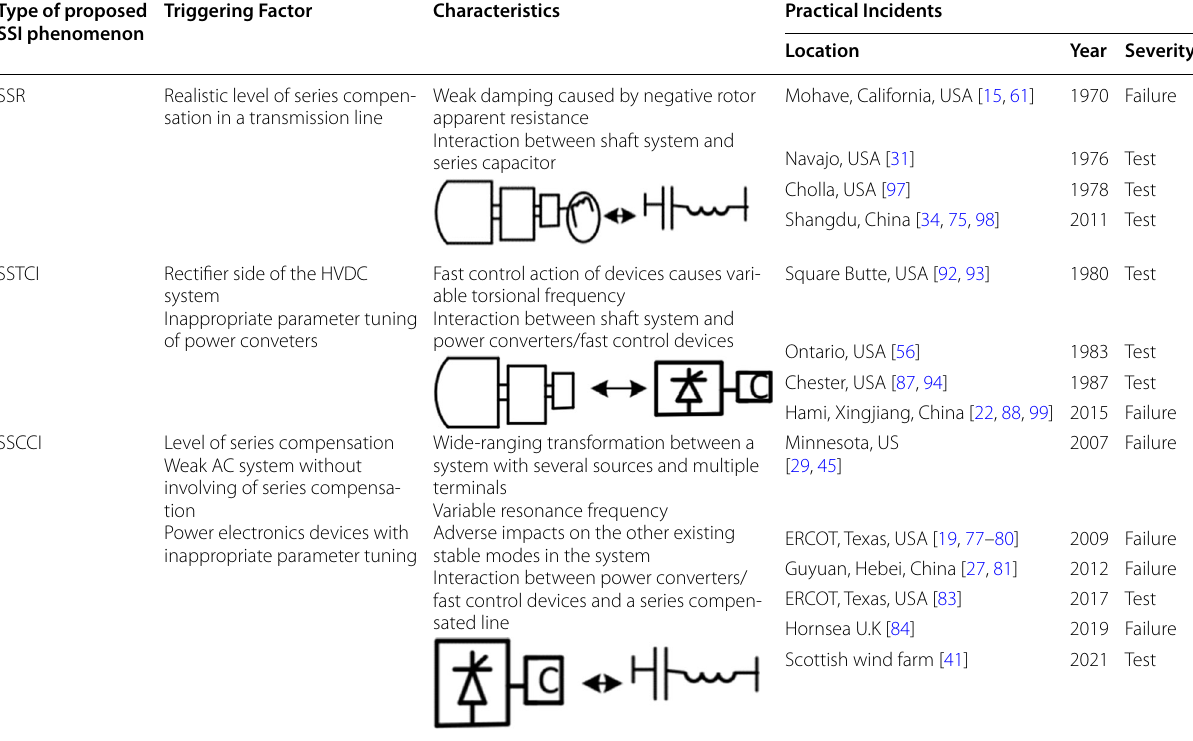
Table 2 Comparison analysis of proposed classifications and historical events due to SSI Type of proposed Triggering Factor Characteristics SSI phenomenon